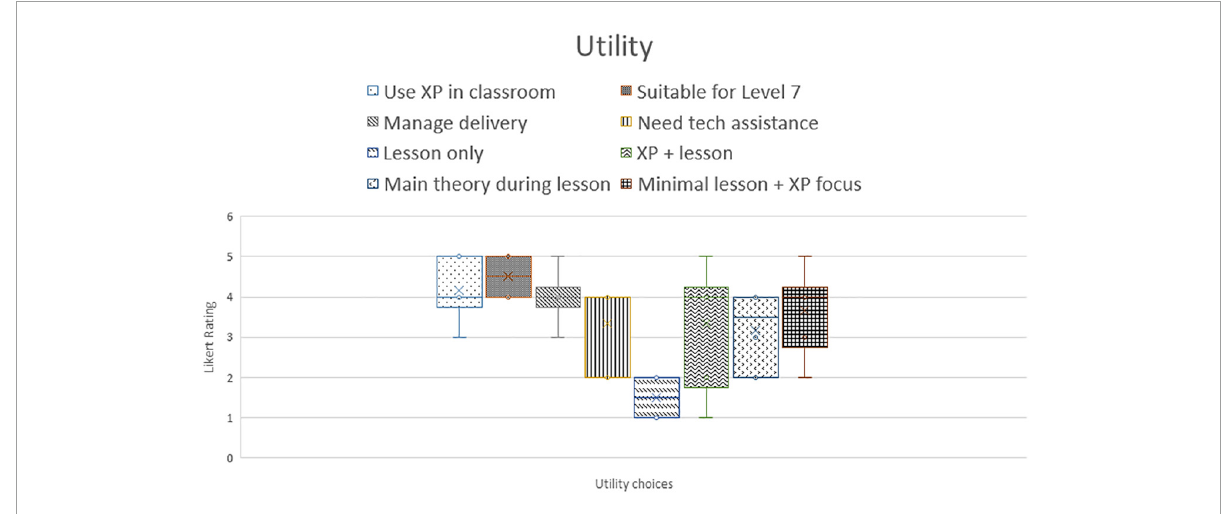
FIGURE9 Utility of experience to the